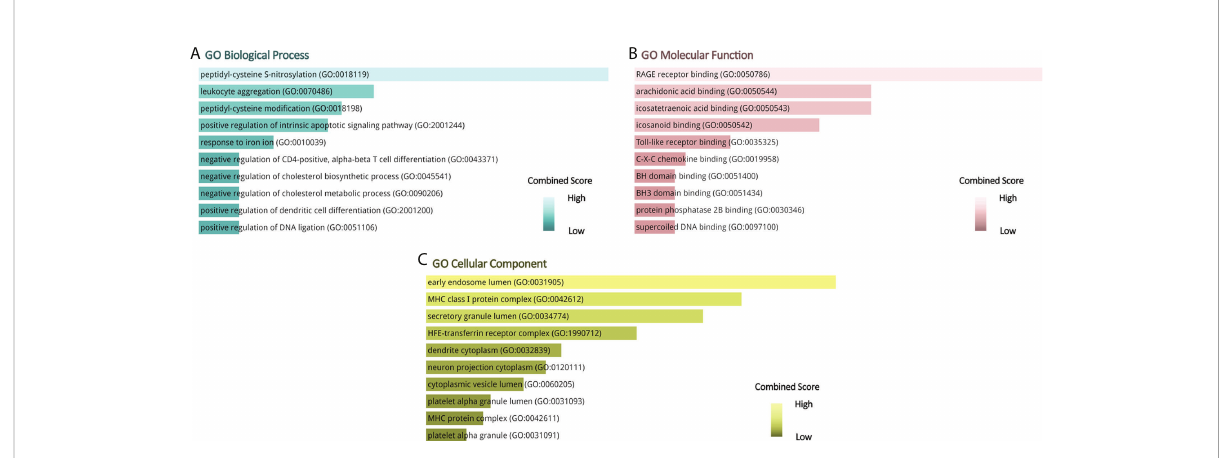
FIGURE 3 GO terms of common genes between long COVID and ME/CFS. (A) Biological Processes, (B) Molecular Function, (C) Cellular Component.